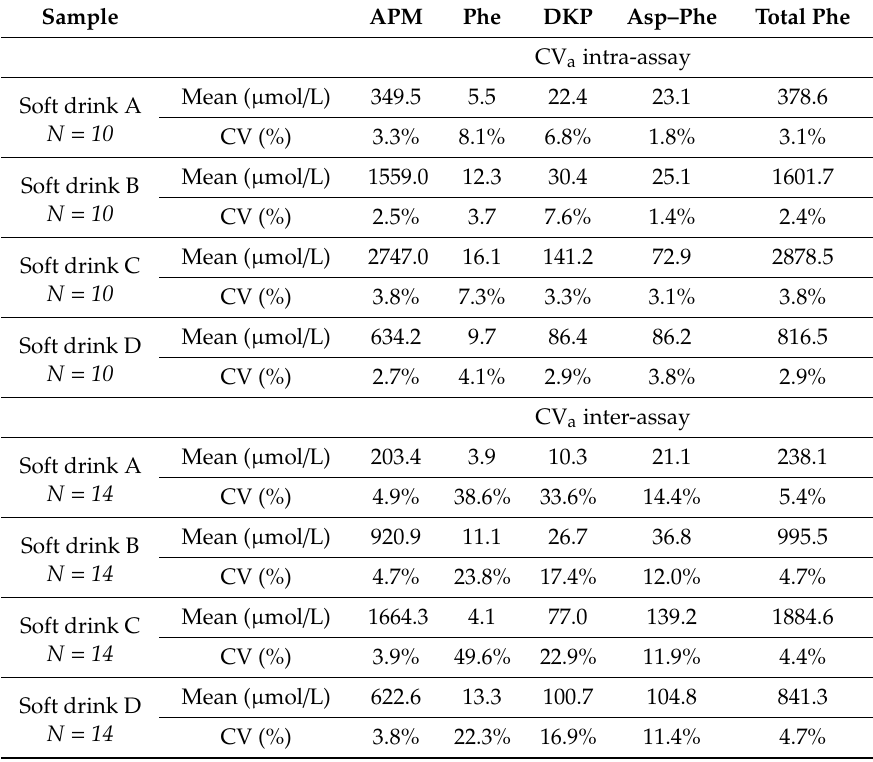
Table 1. Intra- and inter-assay precision of the method for the analysis of aspartame and its degradation